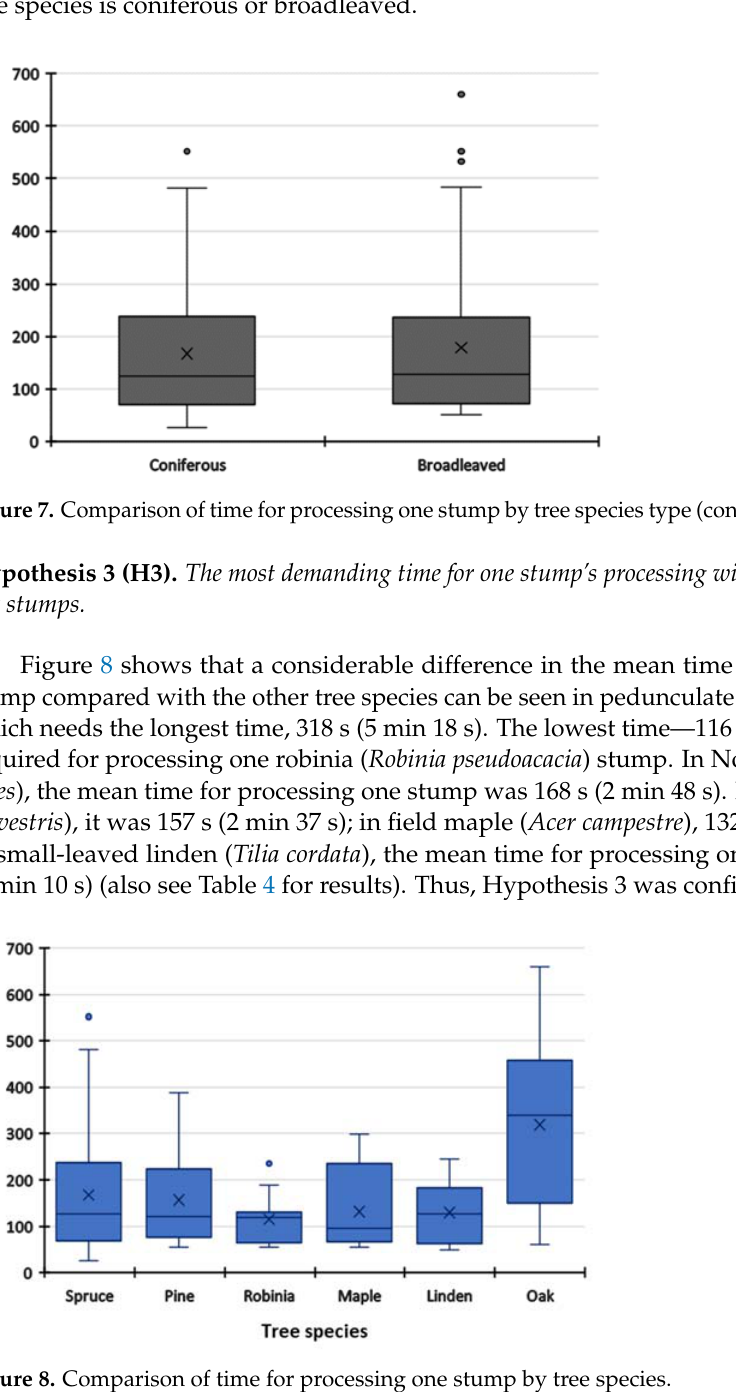
Figure 8. Comparison of time for processing one stump by tree species.